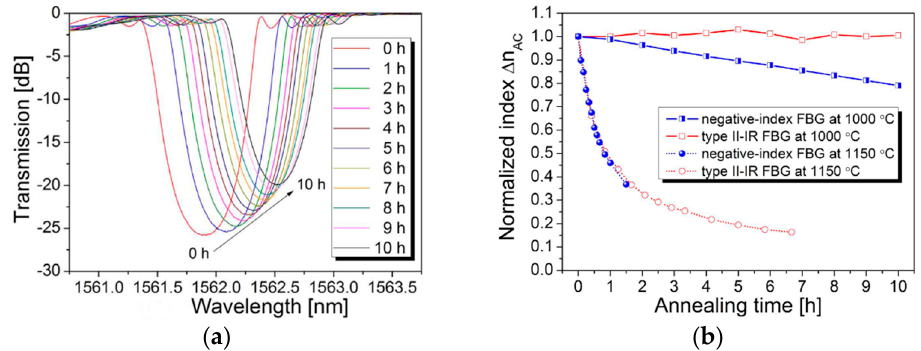
Figure 12. Long-term annealing study of the negative-index FBG. (Reprinted with permission from Ref. [143]). ( a ) Transmission spectra evolution of the negative-index FBG at 1000 ◦ C. ( b ) Evolution of normalized index modulation ( ∆ n AC ) of the negative-index FBG and the typical type II-IR